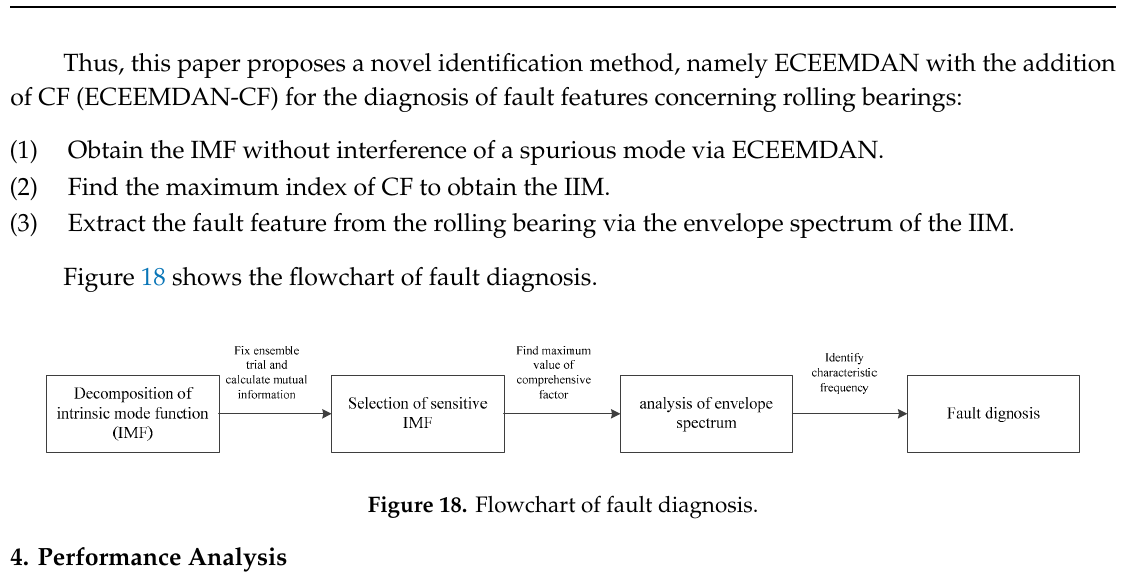
Table 7. Bearing parameter of 6205-2RS deep groove ball bearing.